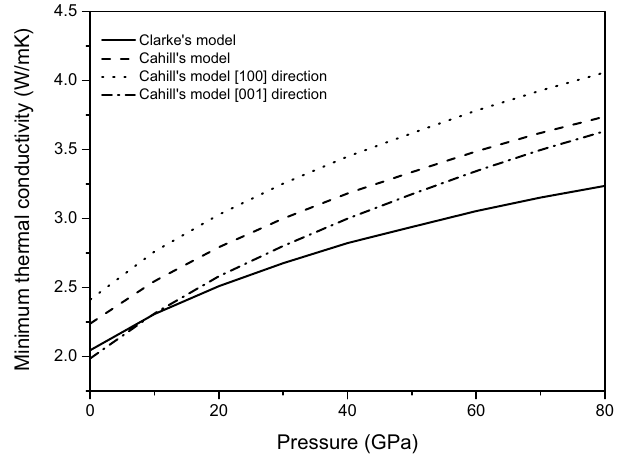
Figure 13. Minimum thermal conductivity of magnesite from 0 to 80